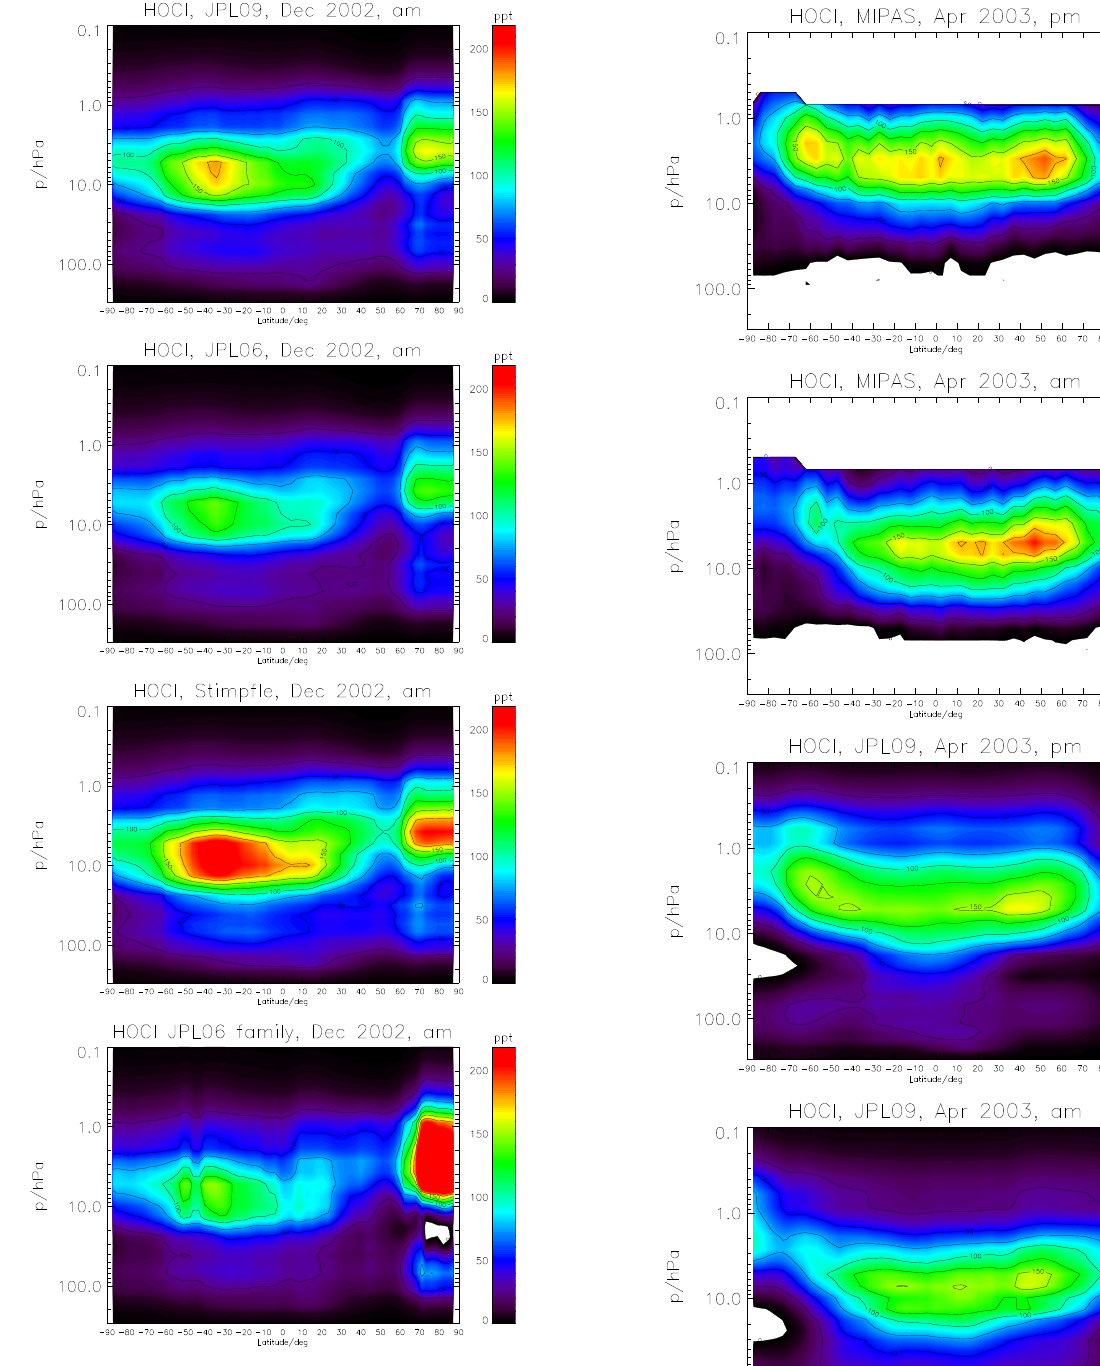
Fig. 5. Timeseries of HOCl zonal mean molar mixing ratios for the equatorial region 25 ◦ S–25 ◦ N. Measurements of the descending part of the orbit (10:00 a.m.) are shown.